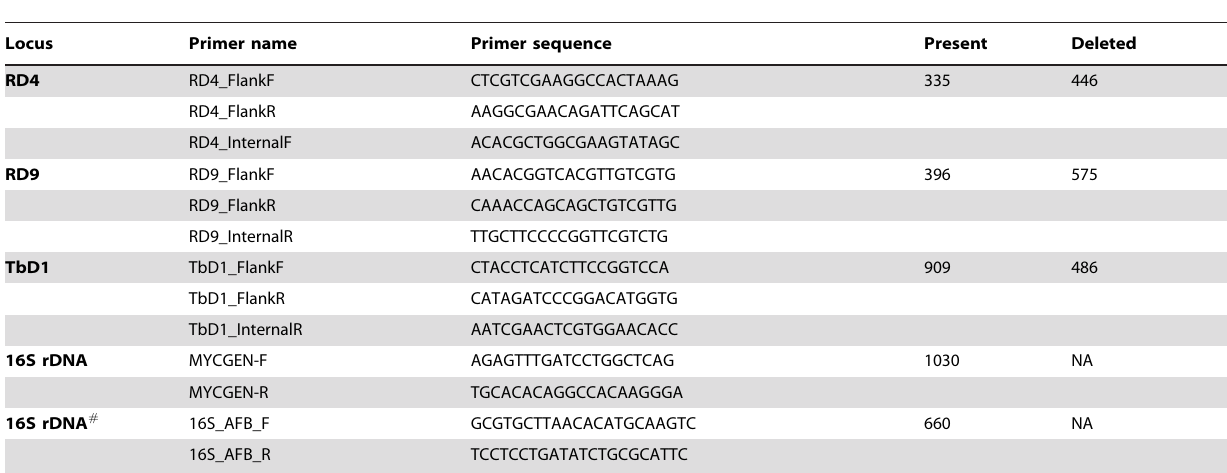
Table 1. Oligonucleotide primers used for molecular typing of Mycobacterium isolates and sizes of the expected PCR products.